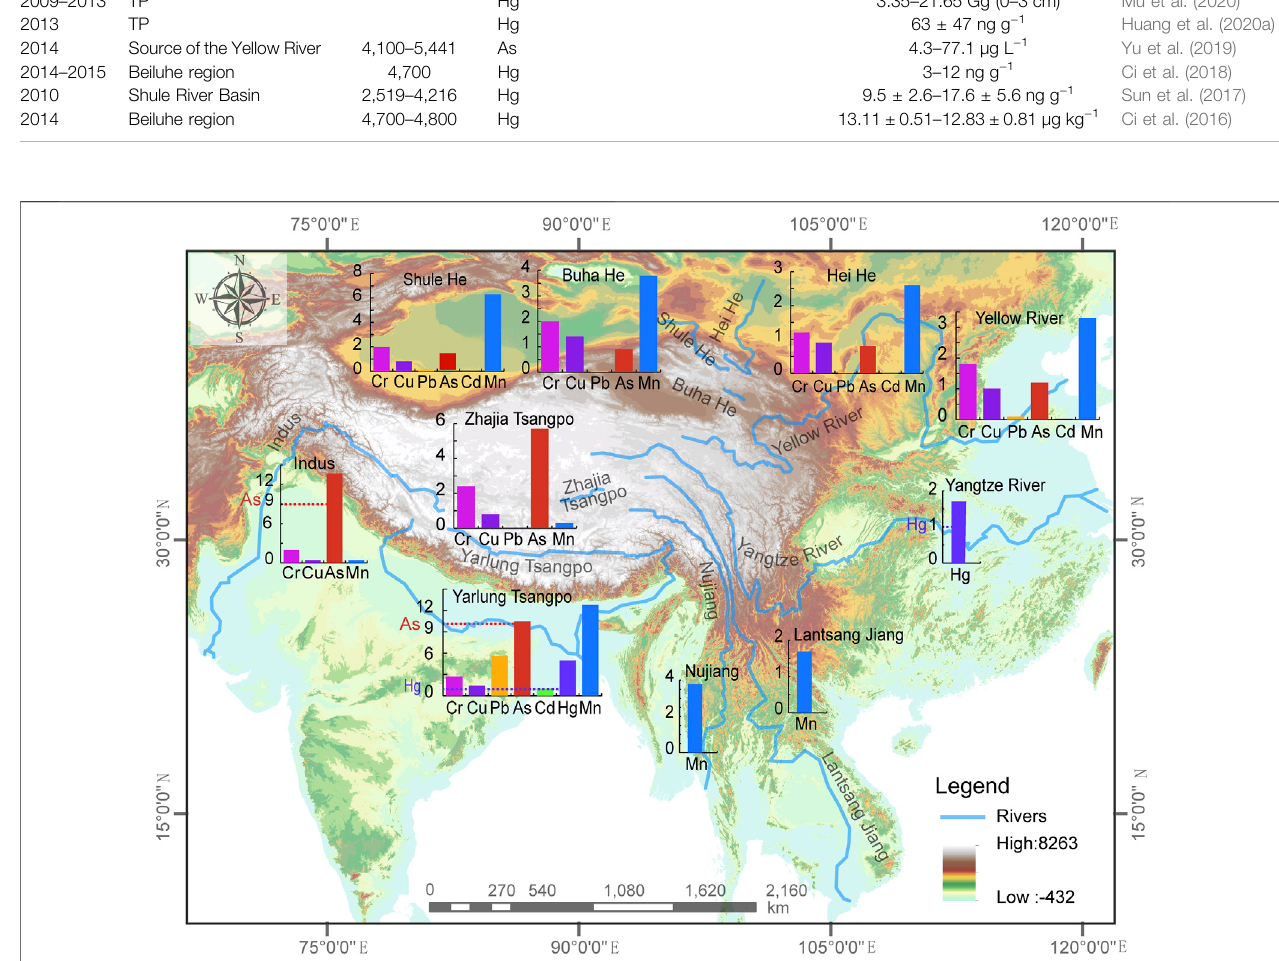
FIGURE 3 | Spatial distribution of main rivers and HMs concentrations ( μ g L − 1 ) in the TP (Qu et al., 2019). Notes: The dotted line is the maximum allowable concentration of HMs in the drinking water, element dates are from Chinese national standards for drinking water quality (MOH and SAC, 2006). If HMs concentrations don ’ t exceed the maximum allowable concentration, no dotted lines are